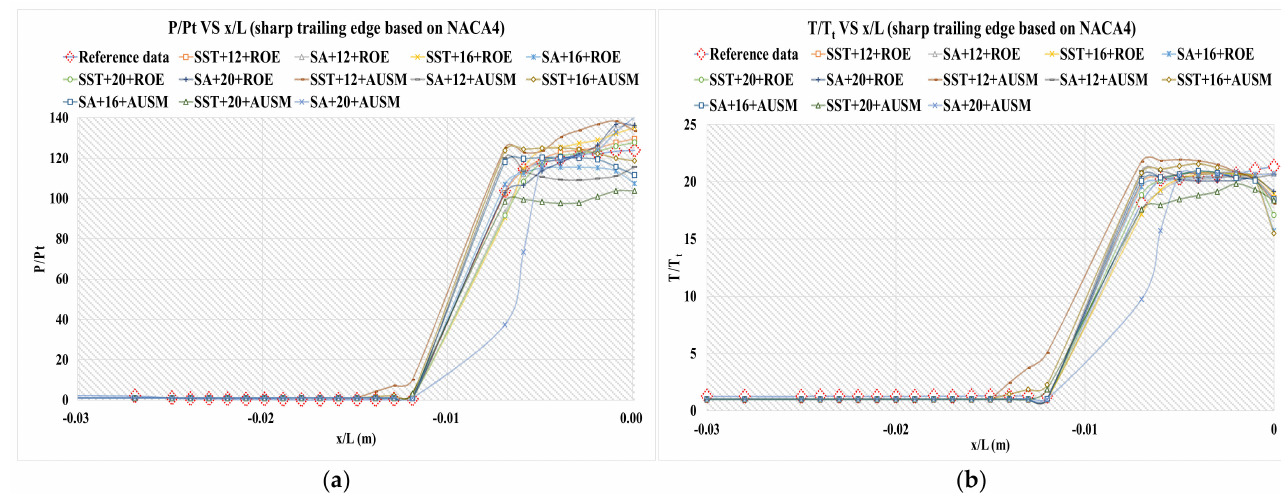
Figure 8. ( a ) Distributions of P/P t of sharp trailing edge based on NACA 4-digital; ( b ) Distributions of T/T t of sharp trailing edge based on NACA 4-digital.